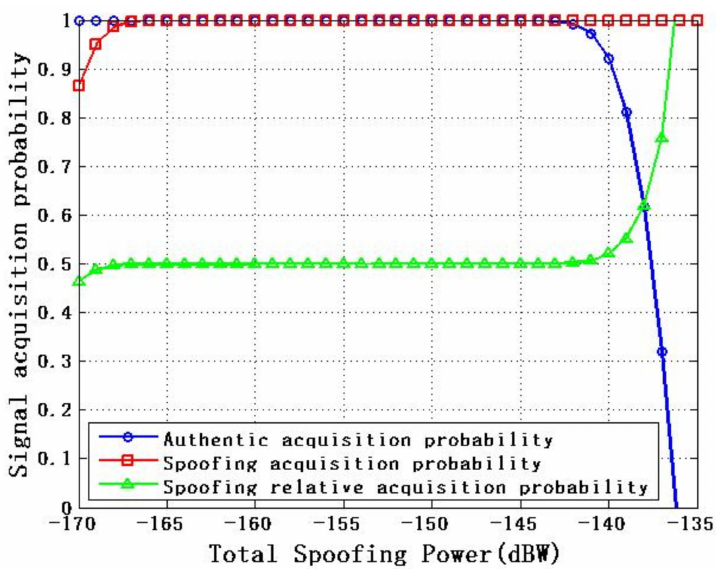
Figure 3. Relationship between total power of spoofing signal and acquisition